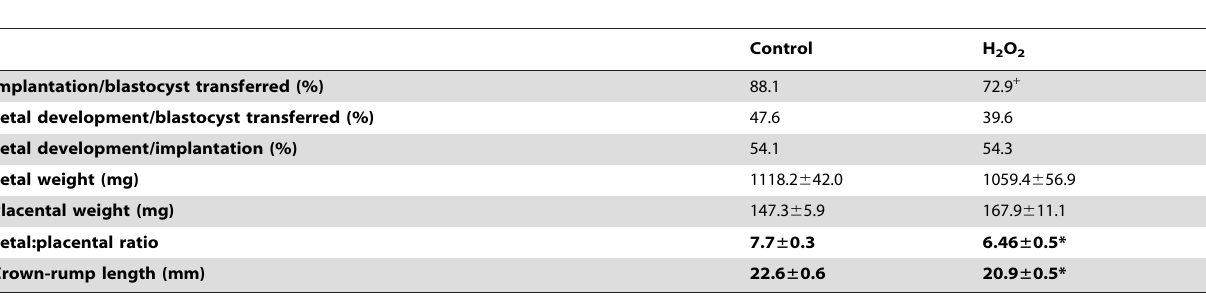
Table 2. Implantation and placental and fetal parameters at day 18 of gestation.